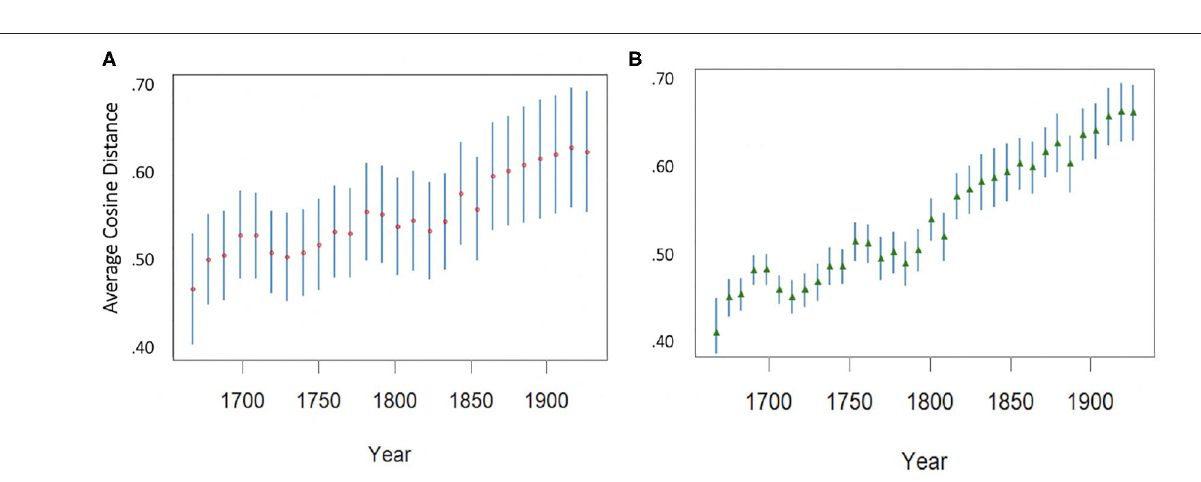
FIGURE 8 | (A) Average distance and standard deviation of 2,000 randomly selected pairs of words. (B) Average distance from the whole vocabulary (mean and standard deviation) of 1,000 randomly selected